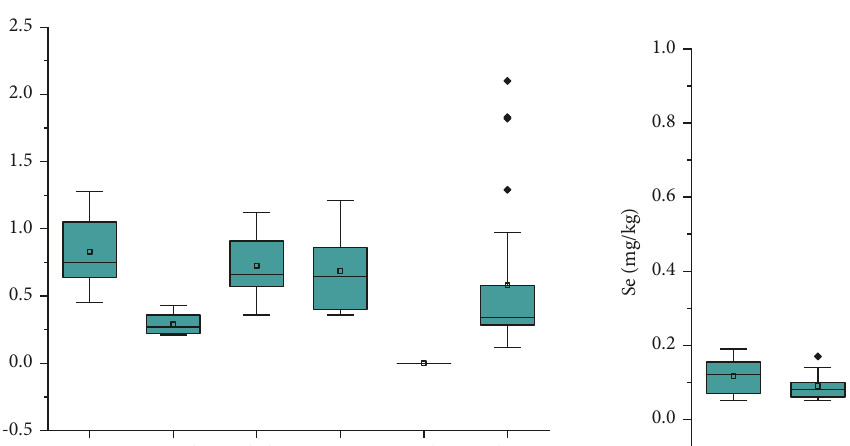
Figure 6: The box plots of As content in tobacco leaf from different countries in tobacco leaf from different countries.